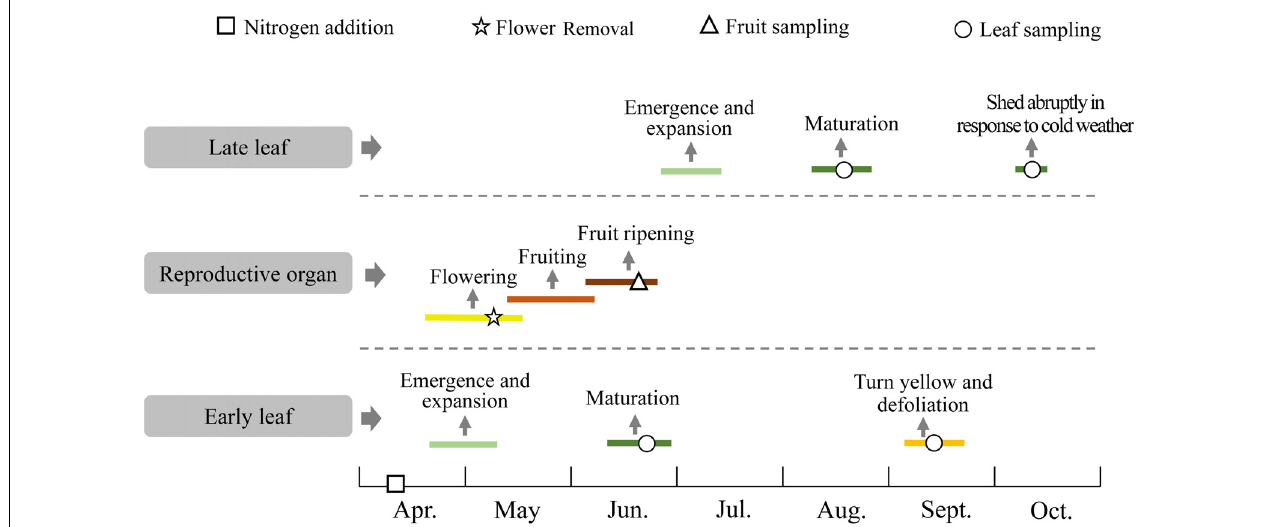
FIGURE 2 | The phenology of Caragana microphylla and the experimental treatment and sampling